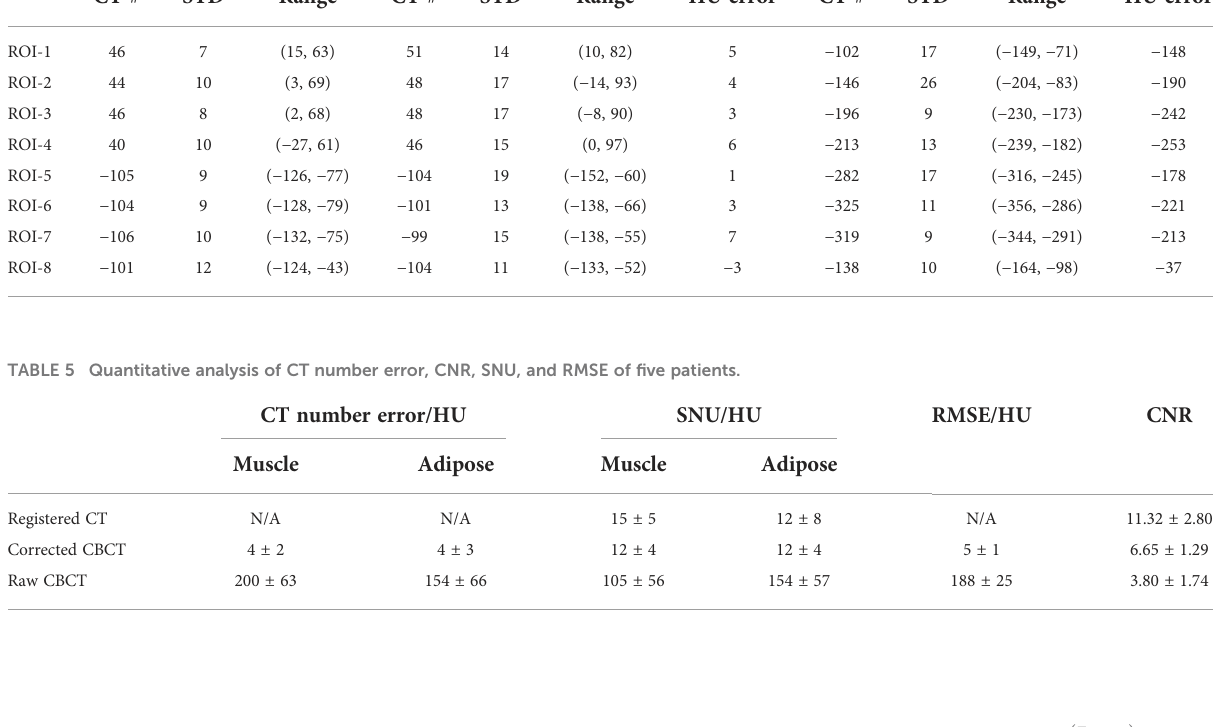
TABLE 6 Average g pass rates for RD_cor of fi ve patients. The second column indicates the distance and dose difference criteria ( (cid:1) x ± s ) .